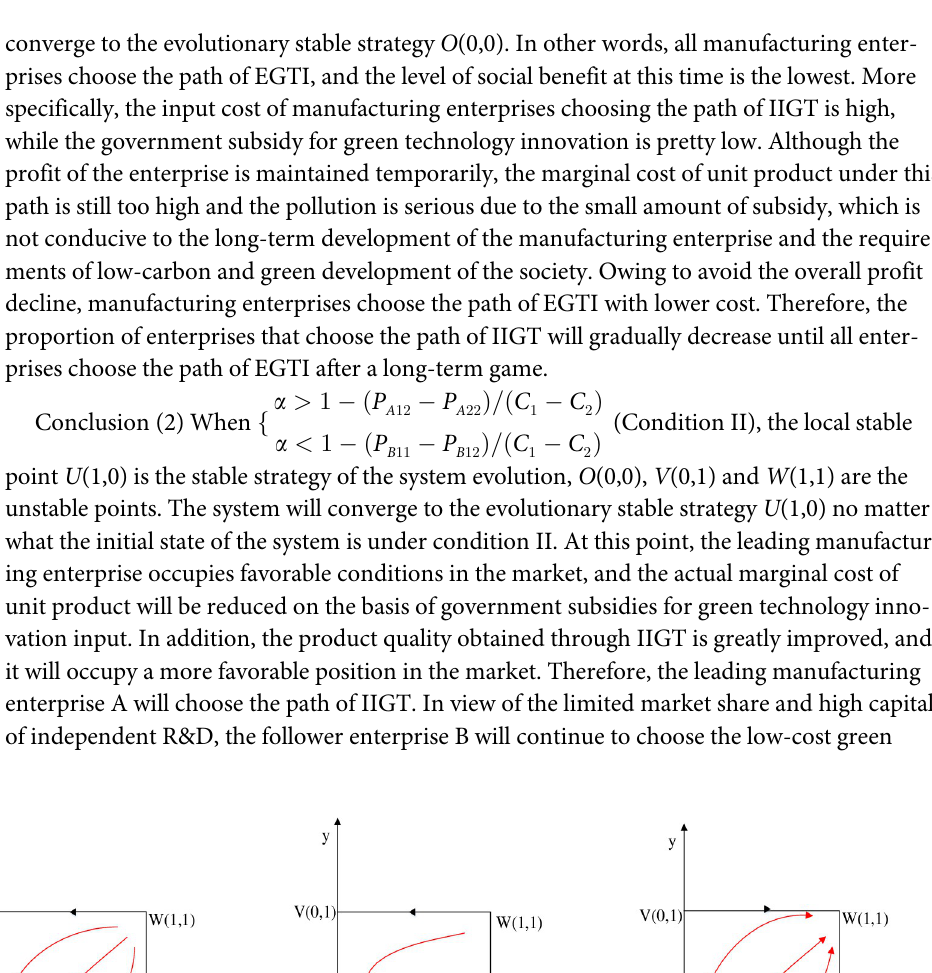
prises choose the path of EGTI after a long-term game.